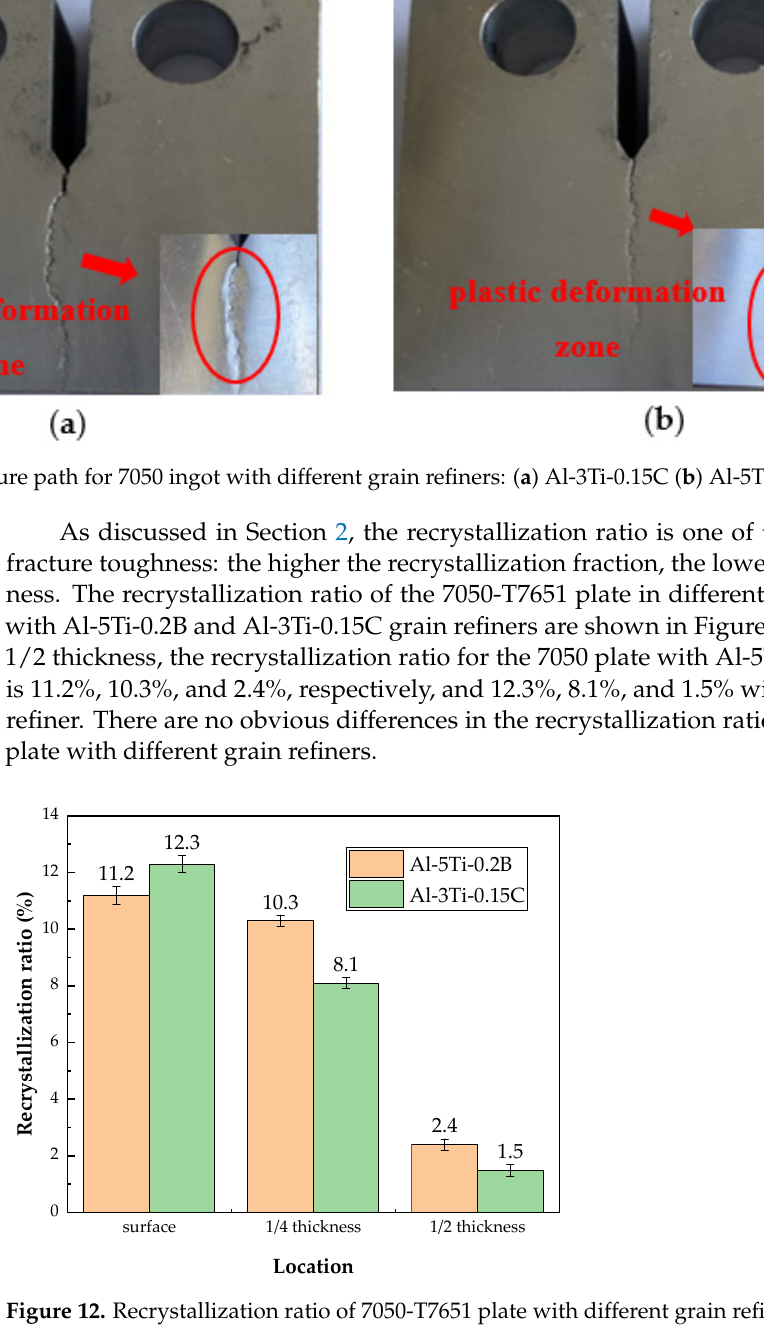
Figure 12. Recrystallization ratio of 7050-T7651 plate with different grain refiners. The Fe and Si bearing phase formed during solidification is brittle and not coherent with the matrix, easily forms pores, and becomes a source of crack propagation, thus strongly reducing the fracture toughness of the alloy. The size of the precipitate and the interface binding force between the precipitate and the matrix have a great influence on the fracture toughness. The larger the size of the precipitate, the weaker the binding force between the phase and the matrix, which leads to the crack occurrence and the inferior fracture toughness. Gokhale, Deshpande et al. [7,28] quantitatively analyzed the relation ‐ ship between microstructure and fracture toughness, and found that the larger the surface area of the second phase particle per unit volume, the lower the fracture toughness. There ‐ fore, in order to improve the fracture toughness of 7050 products, the content of Fe and Si and the size of the dispersion phase must be strictly controlled. In the 7050 ‐ T7651 plate with Al ‐ 5Ti ‐ 0.2B grain refiner, TiB 2 particles are easy to gather in the process of casting and have a genetic effect; TiB 2 particles act as heterogeneous nucleation to precipitate in the aging process. The large precipitate phase will be become the source of cracks, which may reduce the local plastic deformation ability and also the fracture toughness. 5. Conclusions A study has been performed on the effect of grain refiner on the tensile property and fracture toughness of 7050 ingots and 7050 ‐ T7651 100 mm thick plate. The following con ‐ clusions may be drawn from this work. The experiments showed that the grain size from surface to center of the ingot with the addition of Al ‐ 5Ti ‐ 0.2B grain refiner was 95.99 μ m,101.04 μ m, and 121.96 μ m, respec ‐ tively, and 127.31 μ m, 140.50 μ m, and 165.32 μ m with the addition of Al ‐ 3Ti ‐ 0.15C grain refiner. The refining ability of Al ‐ 5Ti ‐ 0.2B grain refiner was better than that of Al ‐ 3Ti ‐ 0.15C. For both 7050 ingots and 7050 ‐ T7651 100 mm thick plate, the tensile property with Al ‐ 5Ti ‐ 0.2B grain refiner was higher than that of Al ‐ 3Ti ‐ 0.15C grain refiner. However, the fracture toughness of 7050 ingots and 7050 ‐ T7651 plates made with Al ‐ 3Ti ‐ 0.15C grain refiner was higher than that made with Al ‐ 5Ti ‐ 0.2B grain refiner, and fracture path for the 7050 ingot with Al ‐ 3Ti ‐ 0.15C after heat treatment was more tortuous than for the ingot with Al ‐ 5Ti ‐ 0.2B. The fractured surface for the 7050 ‐ T7651 plate showed both TiB 2 and TiC particles have a granular shape, and the size of the TiB 2 particles was larger than that of the TiC particles. TiC particles were hard to find under the scope of SEM, whereas TiB 2 particles were easy to find and easy to aggregate. The combination of grain size and uniform